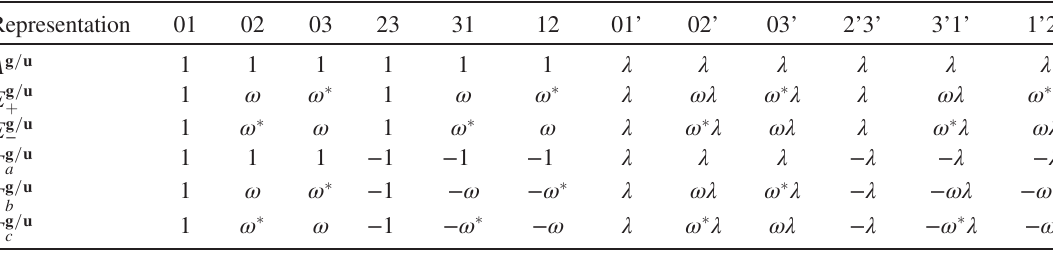
basis states span the two-dimensional representation, and the (cid:2)